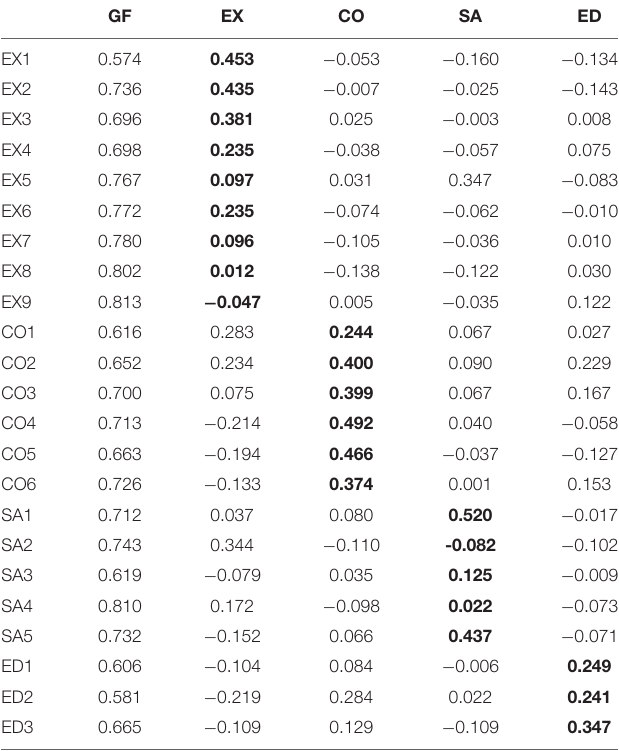
TABLE 3 | Factor loadings of the bifactor ESEM model in the pooled sample.